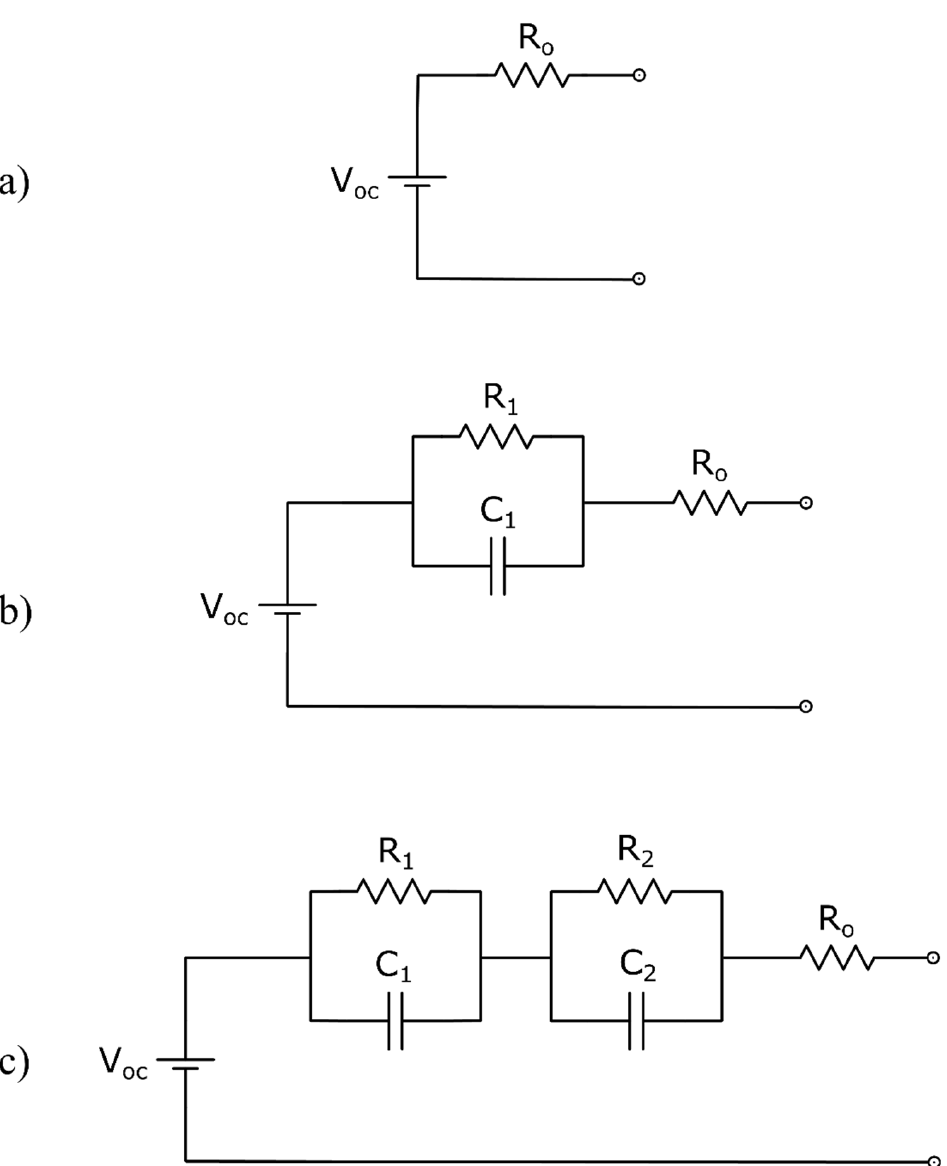
Figure 2. Battery ECM diagrams. ( a ) Internal resistance model, ( b ) one-time constant model, ( c ) two-time constant model.